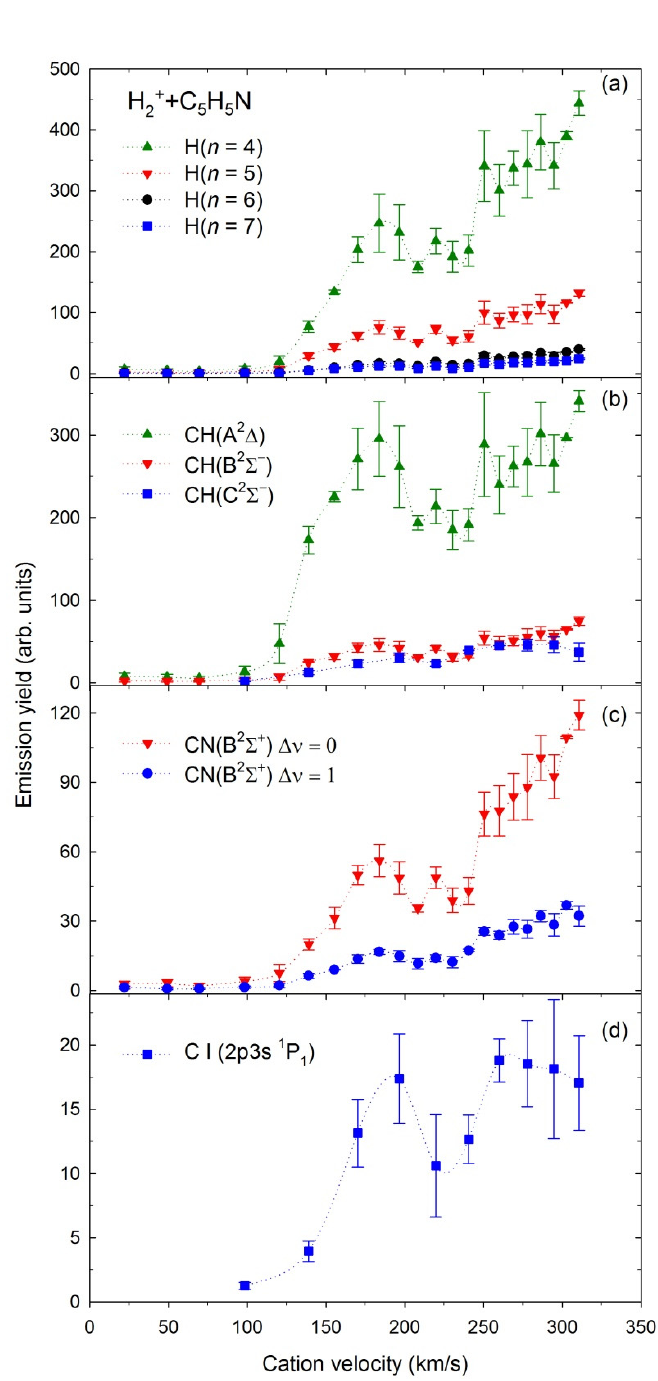
Figure 6. Emission yields of the excited fragments obtained in collisions of H 2+ with pyridine.